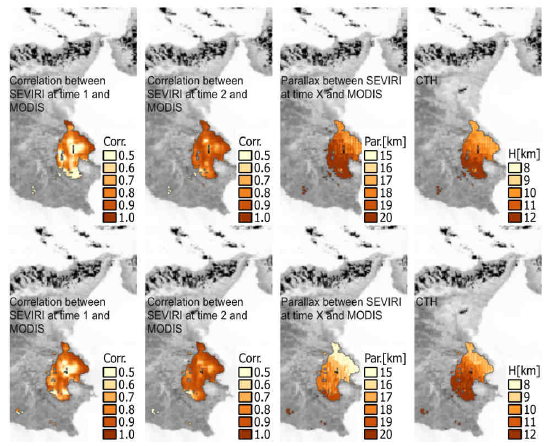
Figure 2. Eruption of Mount Etna as seen from the airport of Catania; note its height (Etna’s peak is 3350 m high). Photo is the courtesy of S. Scollo, INGV Catania).